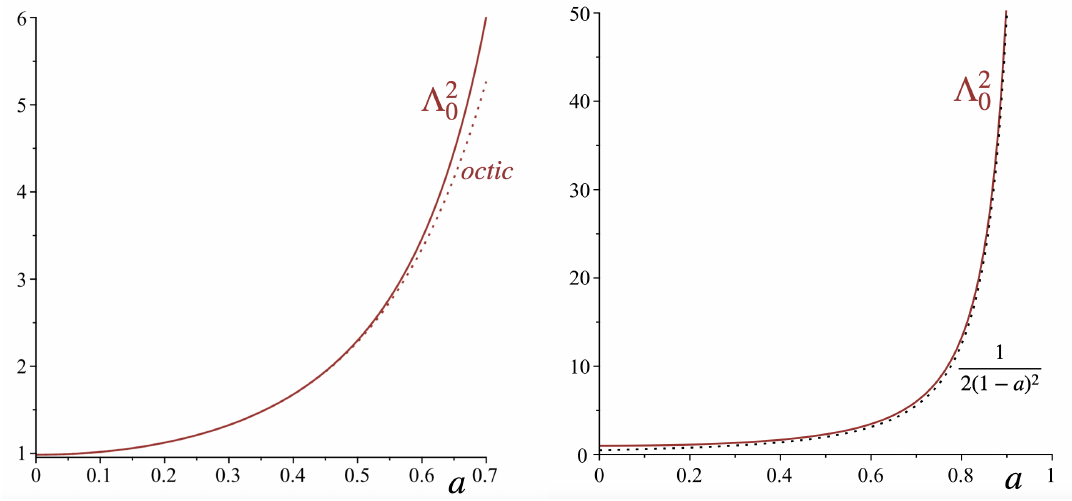
Figure 1 . The metric function Λ 2